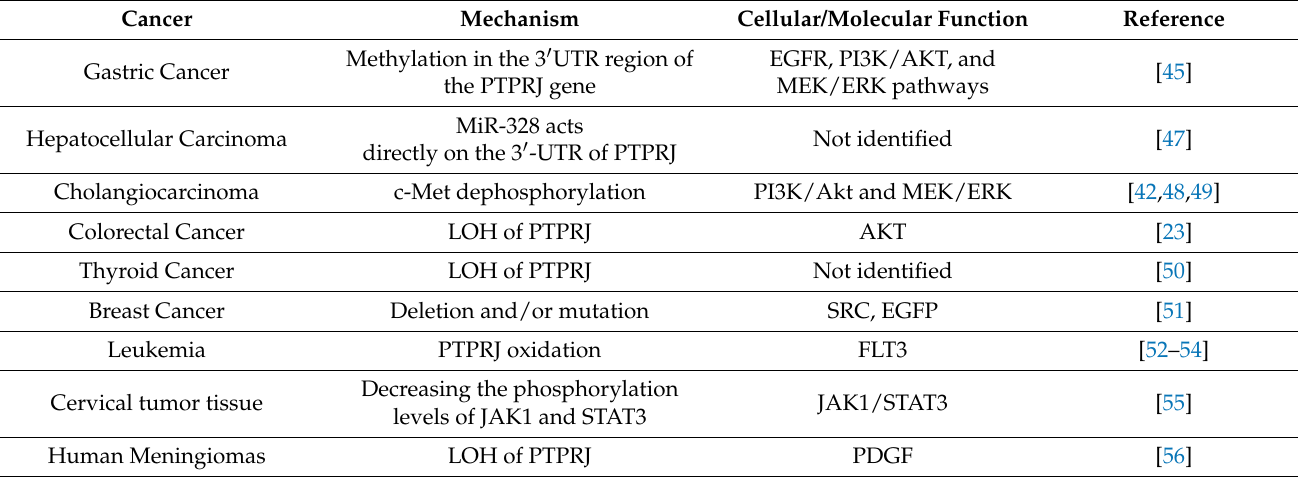
Table 1. Mechanism of protein tyrosine phosphatase receptor type J (PTPRJ) in